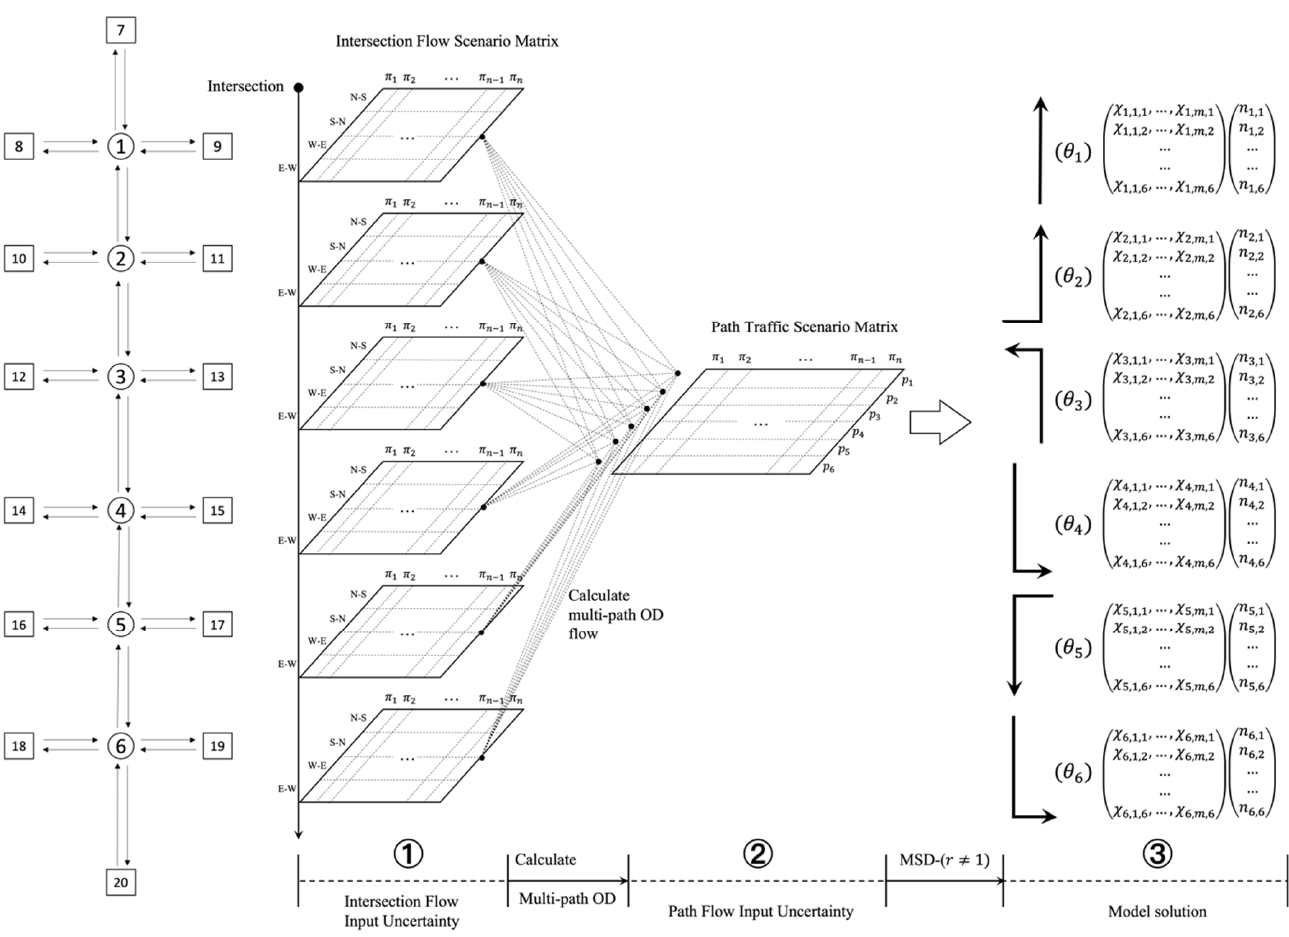
Figure 7. Uncertainty flow scenarios’ generation framework.